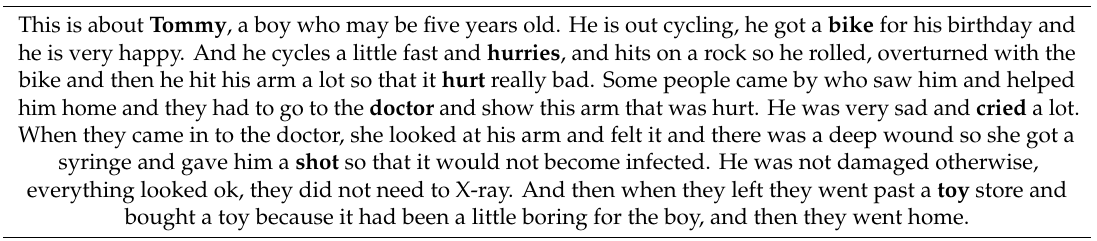
Table 1. Example attachment script assessment (ASA) narratives (“Doctor’s o ffi ce”), with and without secure base